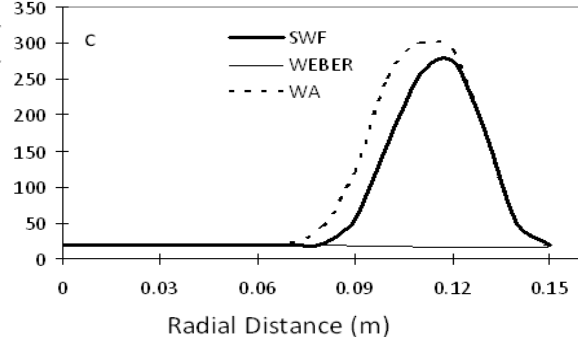
size for Al-He at ( a ) 50 psi (0.34 mpa); 32